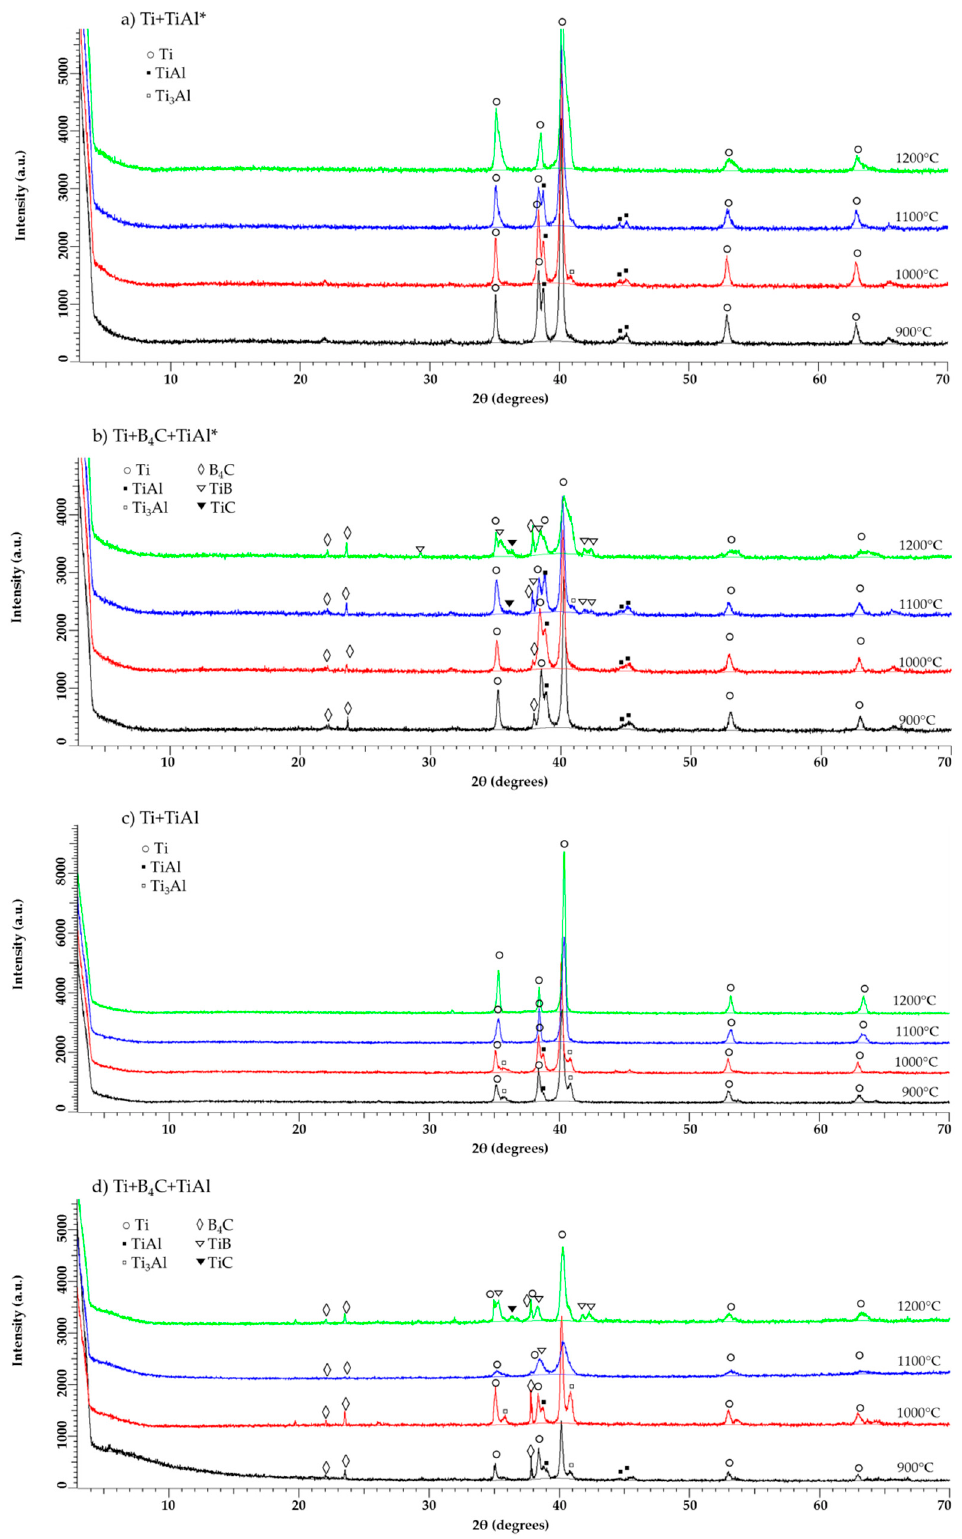
Figure 3. X-ray diffraction (XRD) patterns of the TMCs processed under 40 MPa for 5 min, from the starting materials: ( a ) Ti matrix with TiAl* (prealloyed powder); ( b ) Ti matrix with Ti-Al (Ti-Al blend); ( c ) Ti matrix with TiAl* and B 4 C particles; ( d ) Ti matrix with TiAl and B 4 C particles.